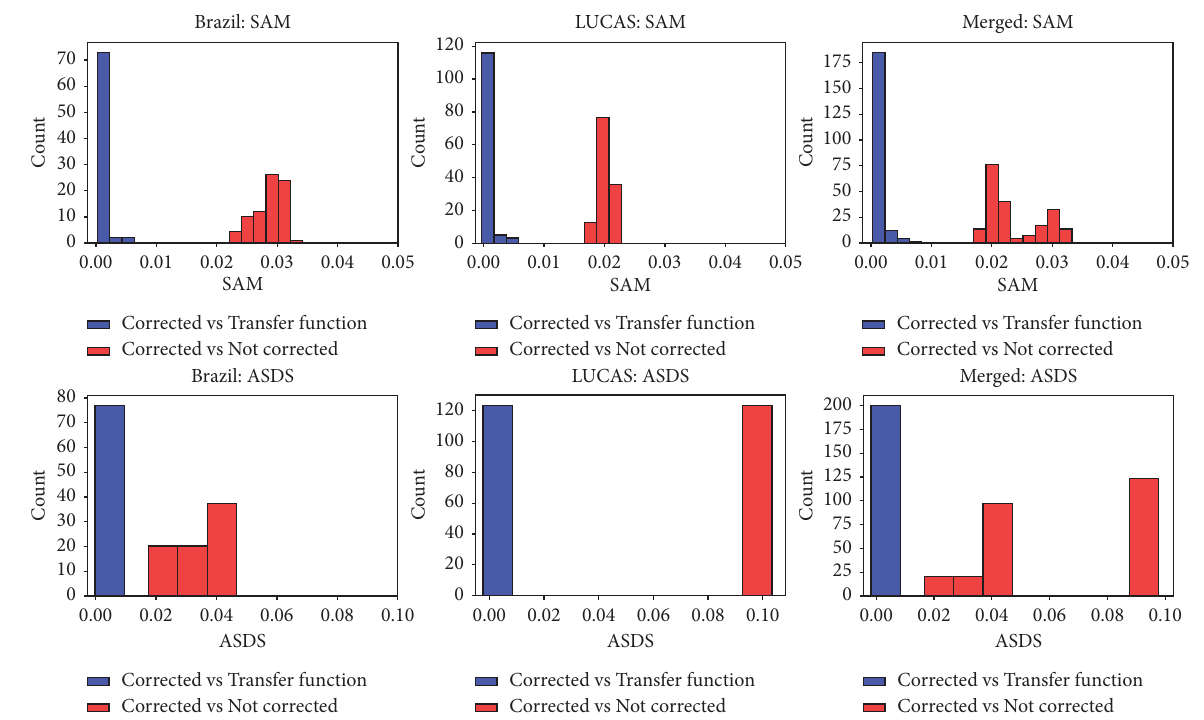
Figure 4: SAM and ASDS histograms from the new measurements. Table 2: Mean ASDS and SAM values before and after executing the TFs1 in the new measurements.